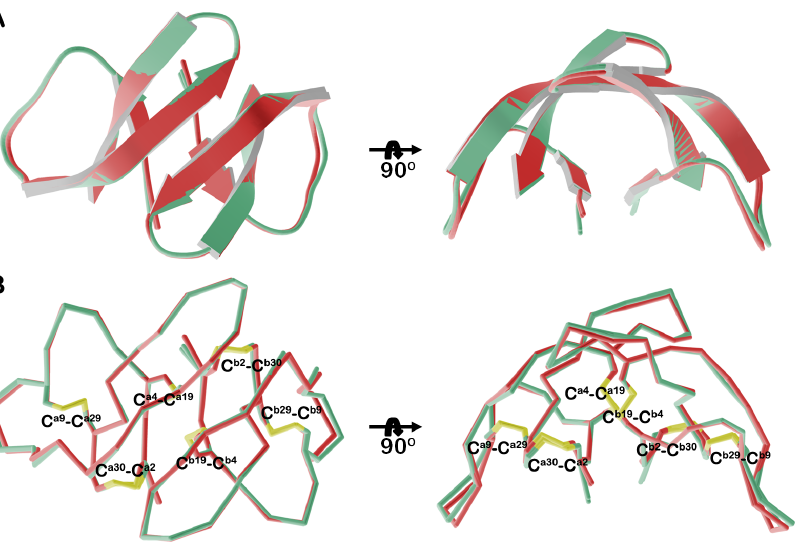
Figure 5. Y16A/F28A and Y16A/I20A/L25A/F28A-HNP1 dimers. (A) Ribbon and (B) a -carbon traces of all Y16A/F28A and Y16A/I20A/L25A/ F28A HNP1 dimers present in the asymmetric unit of the crystal. Y16A/F28A dimers are in green and Y16A/I20A/L25A/F28A dimers in red. Disulfide bonds are shown in yellow. The RMSD is 0.216 A˚ between Y16A/F28A dimers and 0.093 A˚ between Y16A/I20A/L25A/F28A dimers.